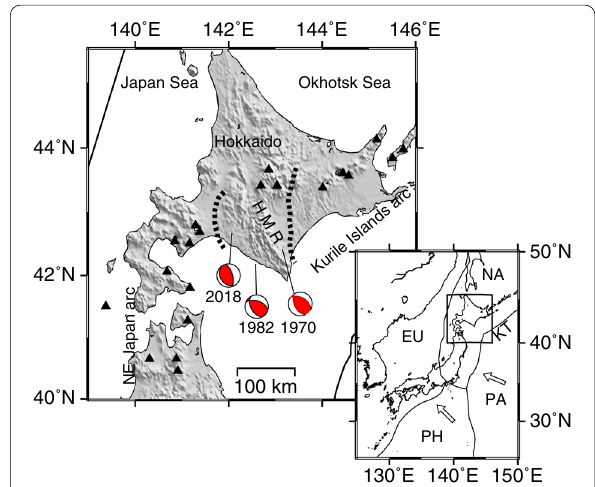
Fig. 1 Map showing the Hokkaido corner. Inset shows the plate boundaries (Bird 2003) and the study area in rectangle. The region in and around the Hidaka Mountain Range (HMR) is the Hidaka Collision Zone (HCZ). Two broken lines show the eastern and the western boundaries of the HCZ. Closed triangles indicate active volcanoes. A red beach ball labeled as 2018 is the centroid moment tensor (CMT) solution of the 2018 Hokkaido Eastern Iburi earthquake (M6.7) (JMA 2018a). A red beach ball labeled as 1982 is the focal mechanism solution of the 1982 Urakawa-oki earthquake (M7.1) by using the first motion polarity of P wave (Moriya et al 1983). A red beach ball labeled as 1970 is the focal mechanism solution of the 1970 Hidaka earthquake (M6.7) by using the first motion polarity of P wave (Kita et al 2012). PA: Pacific plate, PH: Philippine Sea plate, EU: Eurasian plate, NA: North American plate, and KT: Kurile